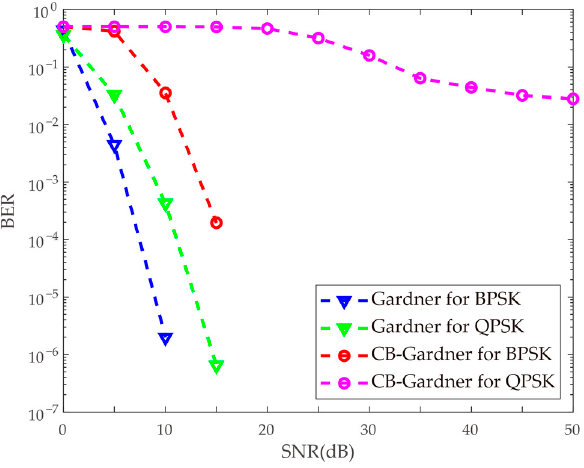
Figure 9. BER for di ff erent SNRs with Gardner and CB-Gardner